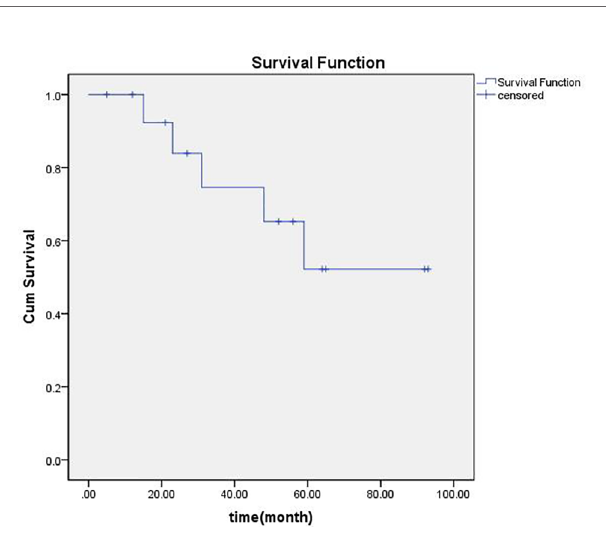
FIGURE 1 | The overall survival rates of the patients after 125 I seed